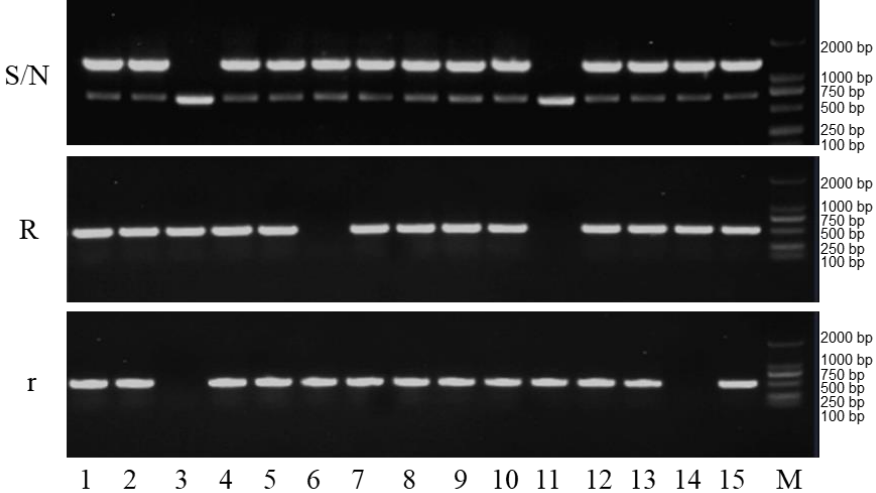
Figure 5. Identification of seed purity for CMS three-line hybrids with the CMS three-line molecular markers. N, fertile cytoplasm gene N; S, sterile cytoplasm gene S; R, fertility nuclear restorer gene; r, recessive nuclear sterile gene; M, DNA marker. The Arabic numbers (1 to 15) indicates different hybrid seedlings.